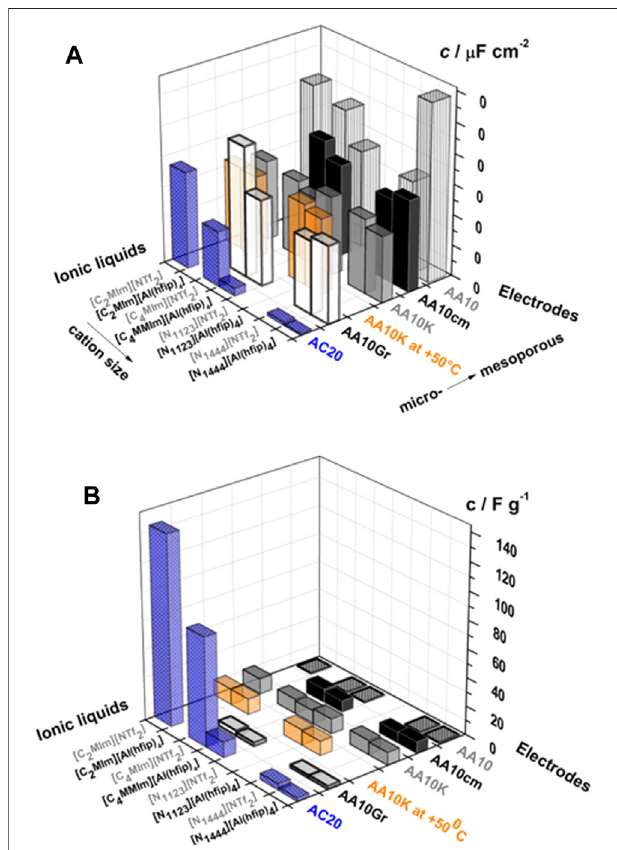
FIGURE4|(A) Speci fi ccapacitancesofvariouscarbonelectrodesinILs with [Al(h fi p) 4 ] − and (Tf 2 N) − anions. (B) Gravimetric capacitances of various carbon electrodes in ILs with [Al(h fi p) 4 ] − and (Tf 2 N) − anions. Reprinted with permission from (Roznyatovskaya et al., 2015), Wiley Online